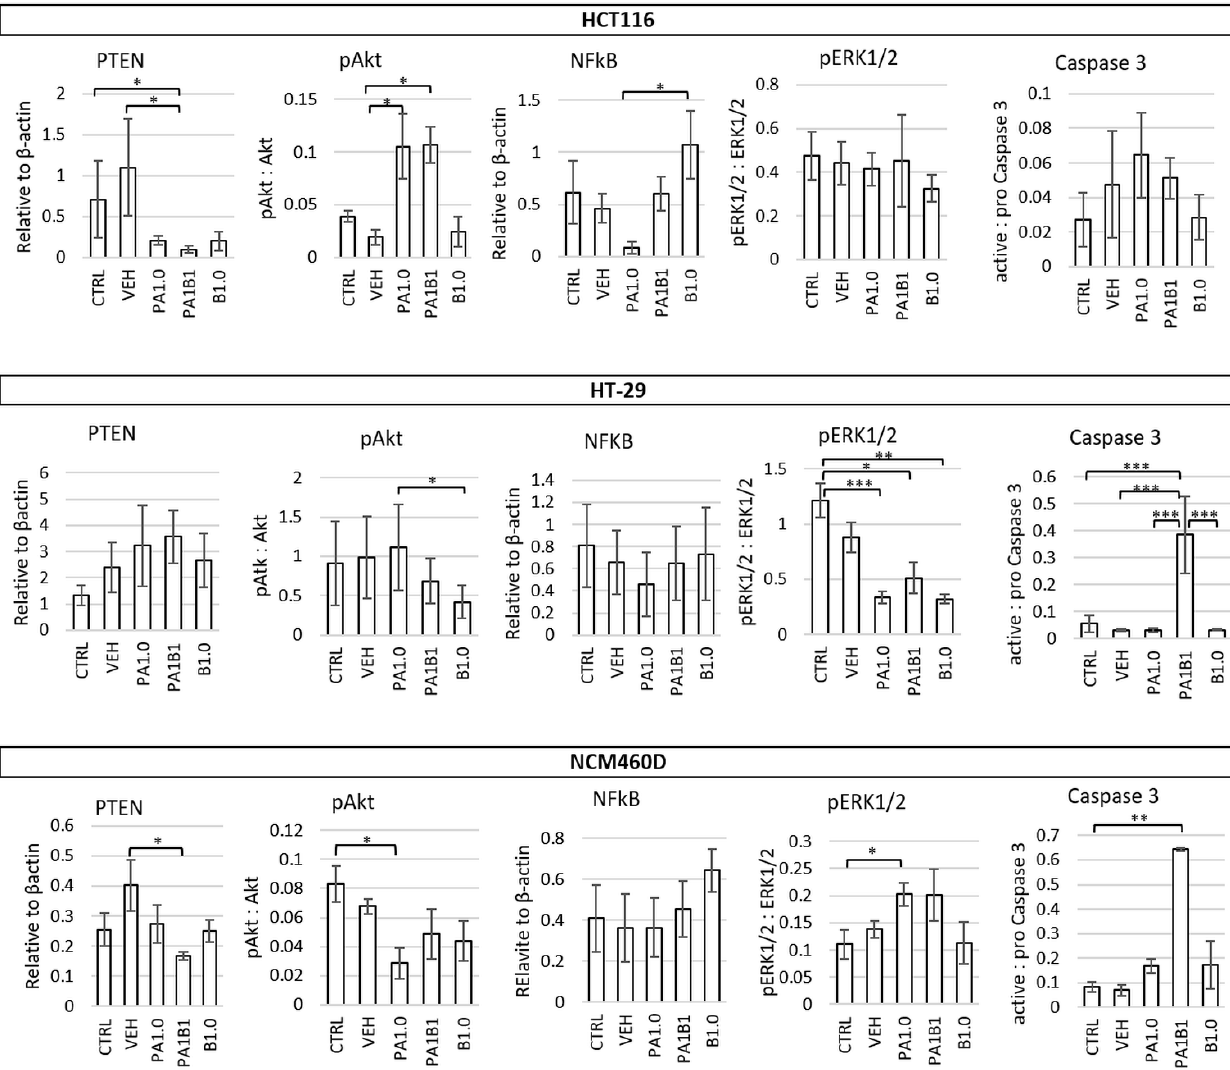
Figure 4. Impact of 1 mM of phytate (PA1.0) and 1 mM of butyrate (B1.0) applied alone or in combination (PA1B1) on the level of cellular proteins or their phosphorylation. PTEN (phosphatase and tensin homolog), pAkt (ratio of phosphorylated to unphosphorylated form of Akt), NF κ B (nuclear factor kappa B p65), pERK1/2 (ratio of phosphorylated to unphosphorylated form of ERK1/2), active caspase 3 (ratio of active form of caspase 3 to pro-caspase 3) in HT116, HT-29, and NCM460D cells. The values are significantly different at p < 0.05, p < 0.01, and p < 0.001 are marked with *, ** and ***, respectively. The effects of phytate and/or butyrate on cellular processes are summarized in Table